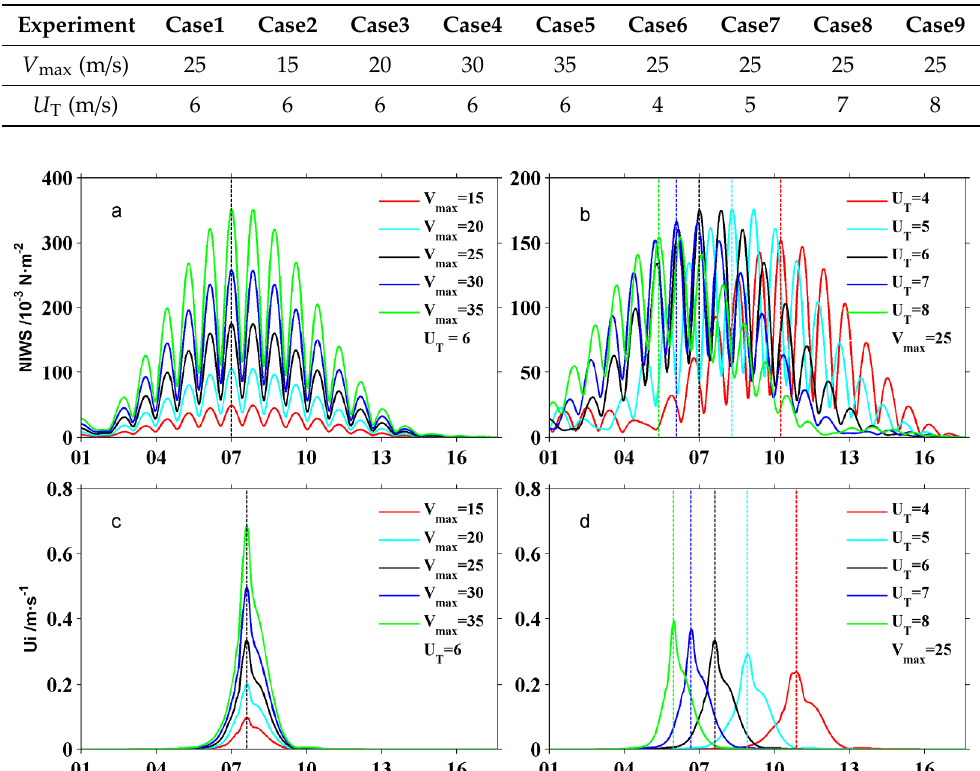
max is the maximum